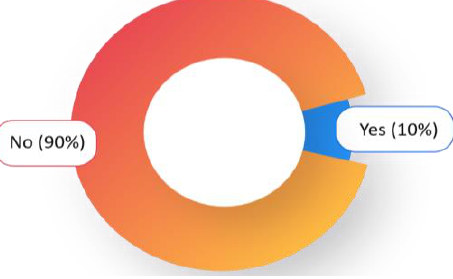
Figure 17. Classification by post-processing techniques.